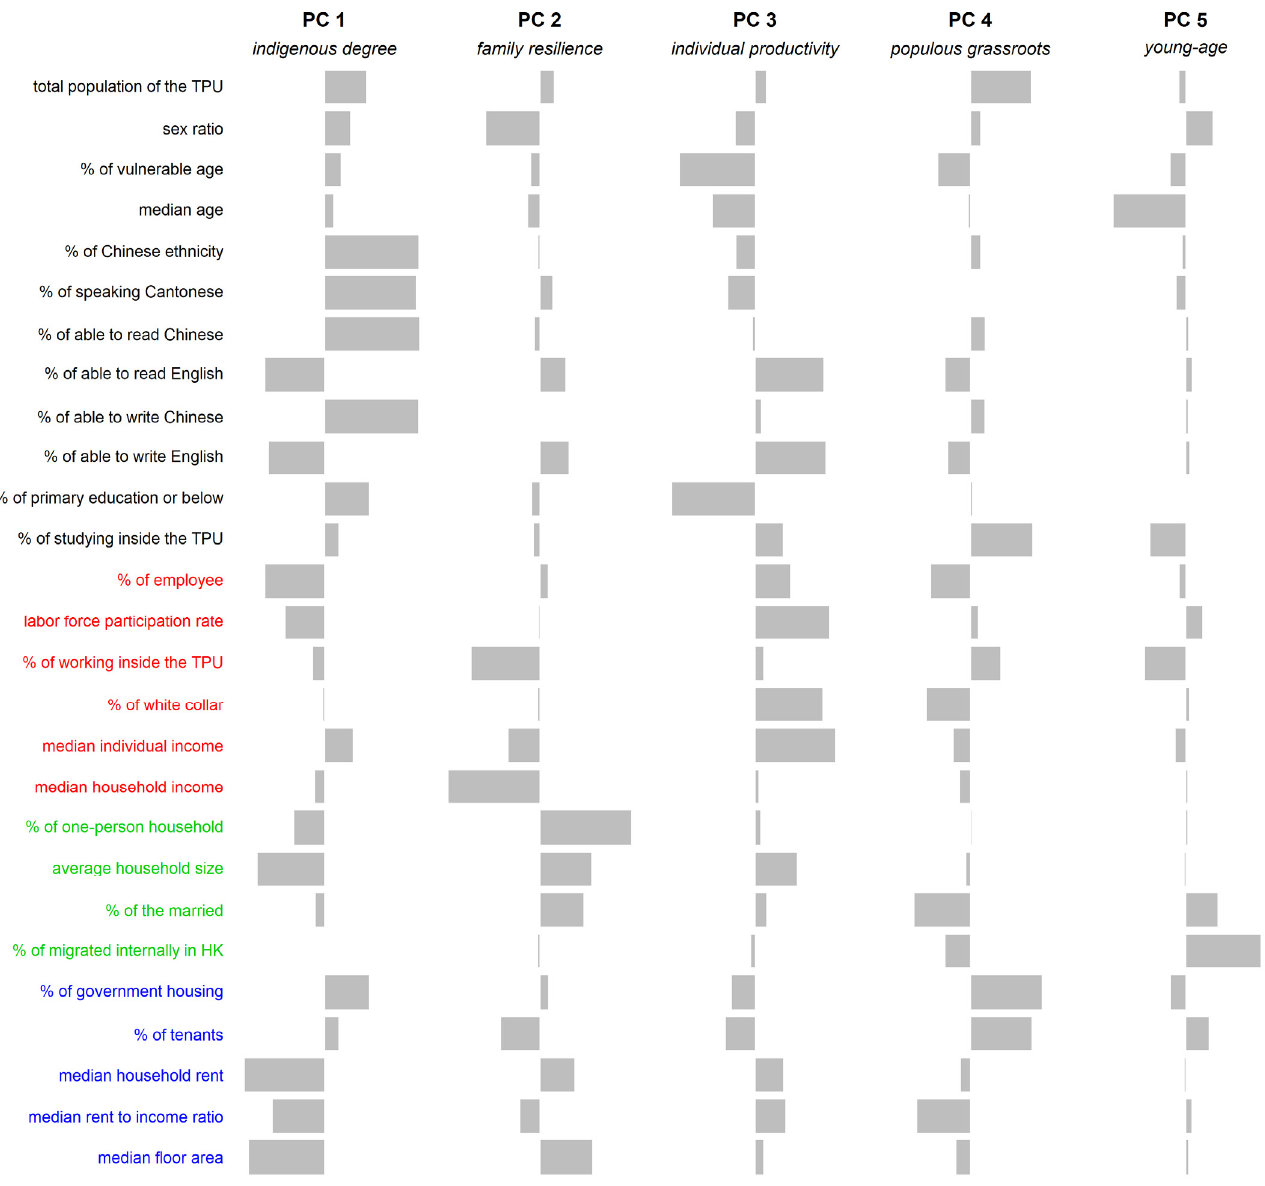
Figure 2. The loadings for the five principal components. Note: The bars depict each correlation coefficient between the original variable and principal component. The signs of the coefficients of the socioeconomic variables do not affect their importance in the principal component while the magnitude of them does. A longer bar indicates higher absolute correlation